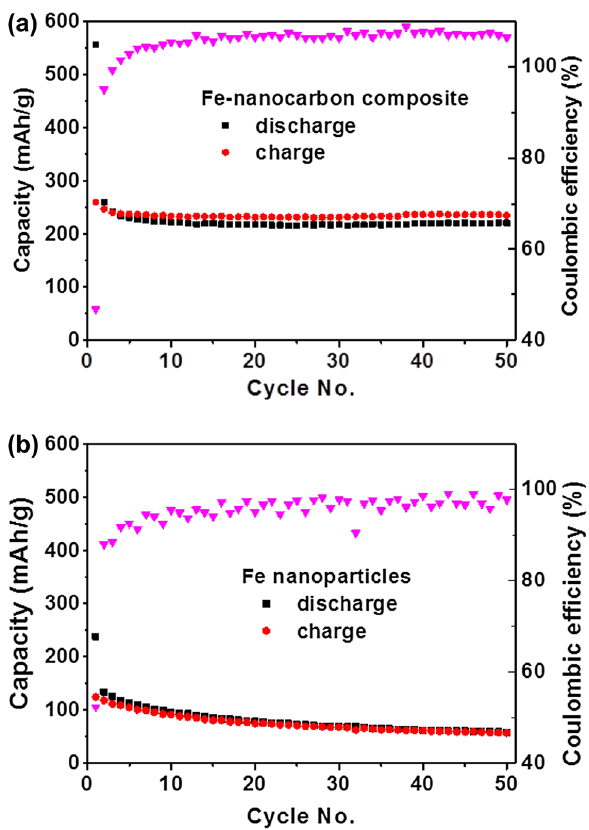
Fig. 4 Cycling performance on a lithium half-cell of: a Fe–C composite electrode, and b as-deposited Fe-based nanoparticle